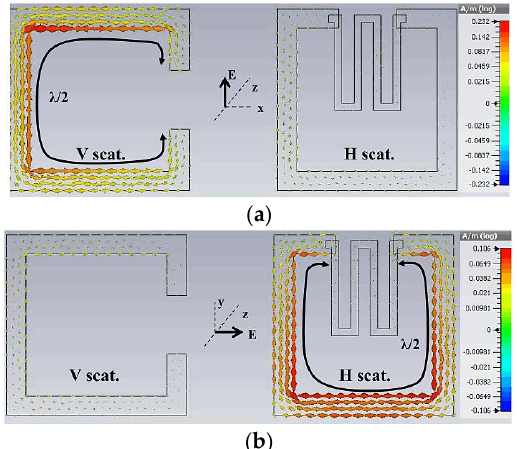
Figure 5. Electric-field distributions at 2.4 GHz for the dual-polarized SRR-based sensor: ( a ) for vertically polarized excitation; and ( b ) for horizontally polarized excitation [51].